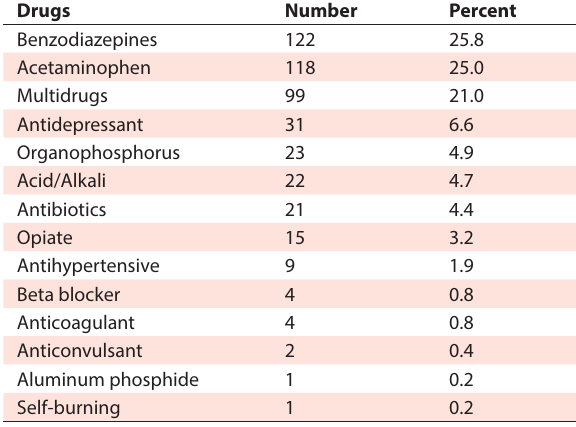
Table 1. Frequency of poisoning agents in patients